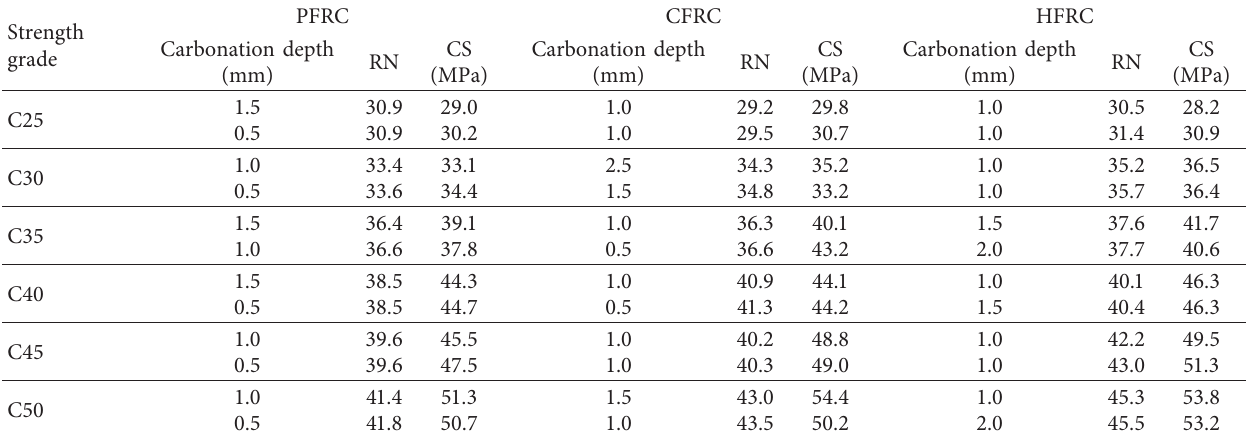
Figure 3: Fracture surface with sprayed phenolphthalein alcohol solution, which distinguishes between carbonated and noncarbonated regions. Table 4: Part of the RN and carbonation